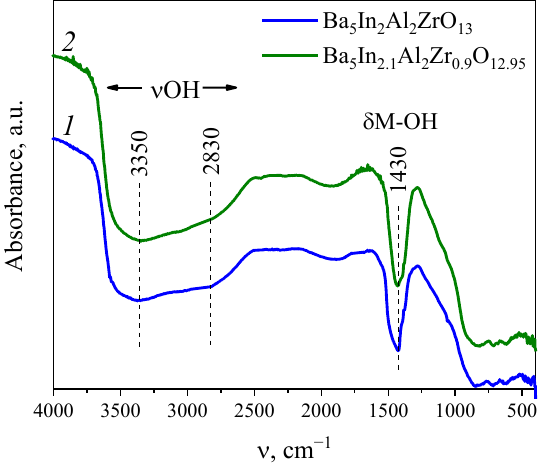
Figure 6. IR spectra of the hydrated samples Ba 5 In 2 Al 2 ZrO 13 ( 1 ) and Ba 5 In 2.1 Al 2 Zr 0.9 O 12.95 ( 2